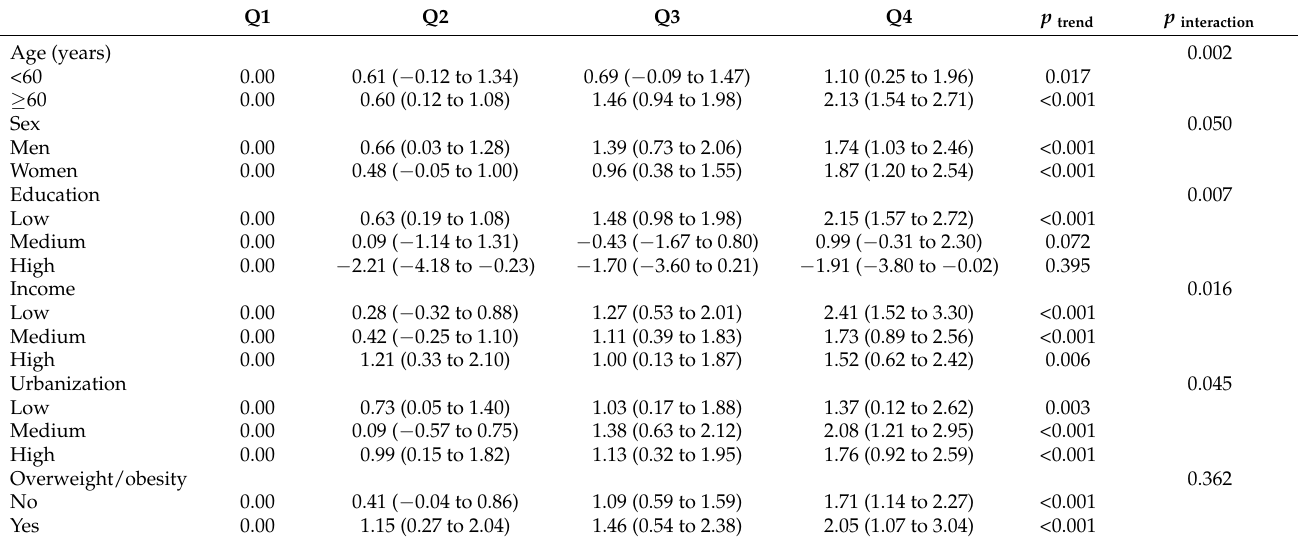
Table 3. Subgroup analyses of the association between quartiles of animal methionine intake and global cognition scores.